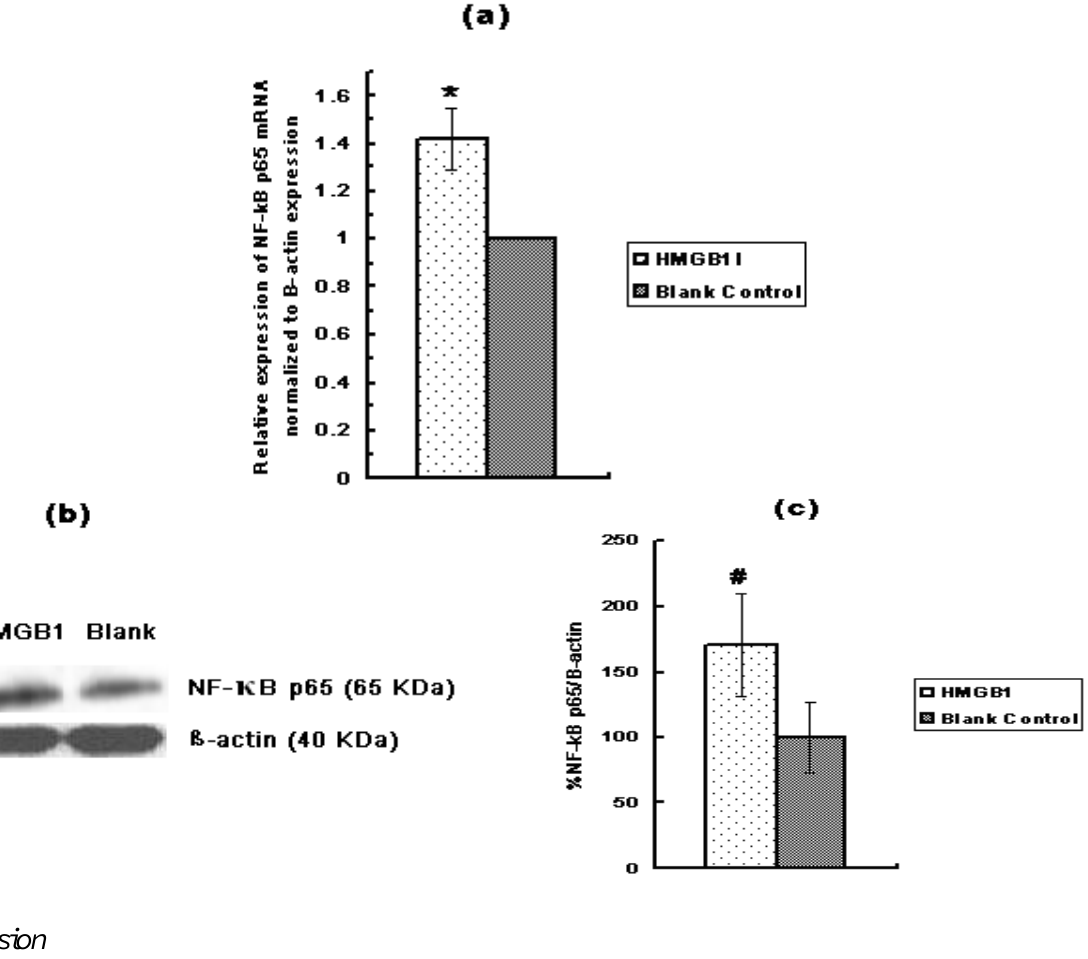
Figure 7. The effect of HMGB1 on the expression of NF-κB p65 in Huh7 cells by qRT-PCR and Western Blot. ( a ) Relative expression of NF-κB p65 mRNA normalized to β-actin expression ( vs. blank control) analyzed by qRT-PCR; ( b ) Western Blot protein bands film results; ( c ) Expression of NF-κB p65 protein as a ratio to β-actin; ( * p < 0.01, # p < 0.05). Three independent measurements were made and